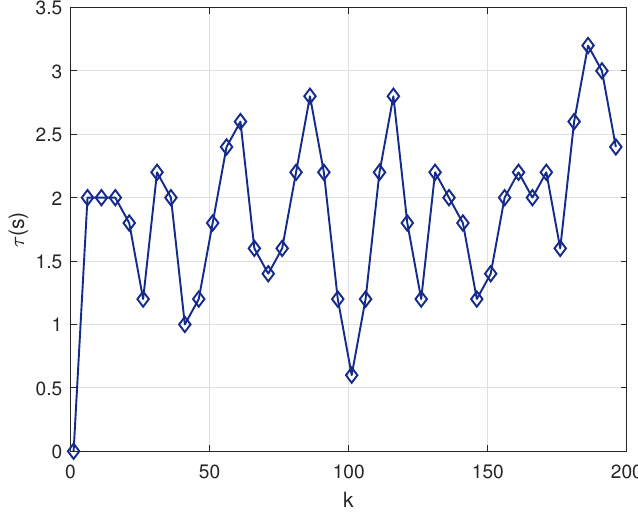
Figure 10. Variation of Sampling Interval τ Over Time.